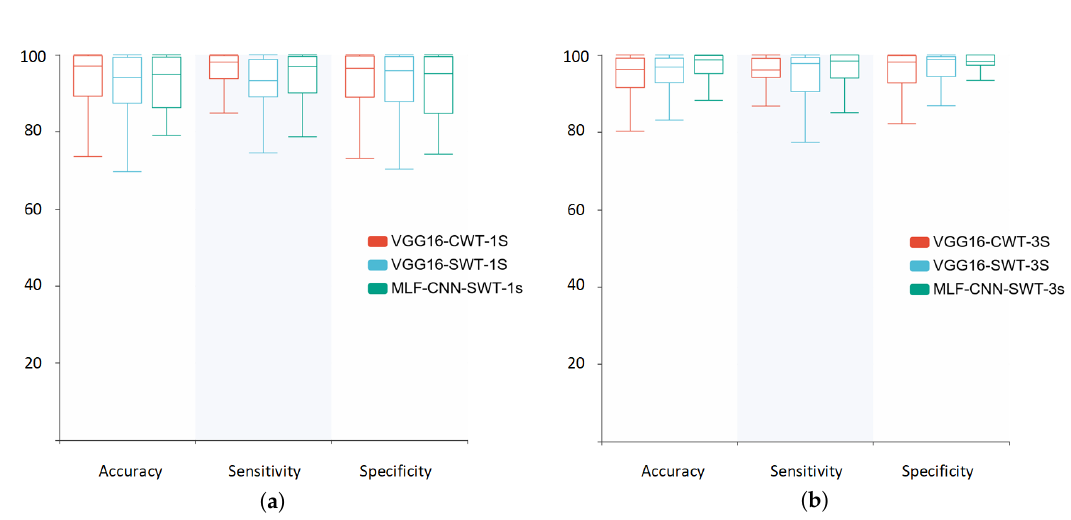
Figure 7. The distribution of experimental results. ( a ) 1 s segments, ( b ) 3 s segments.